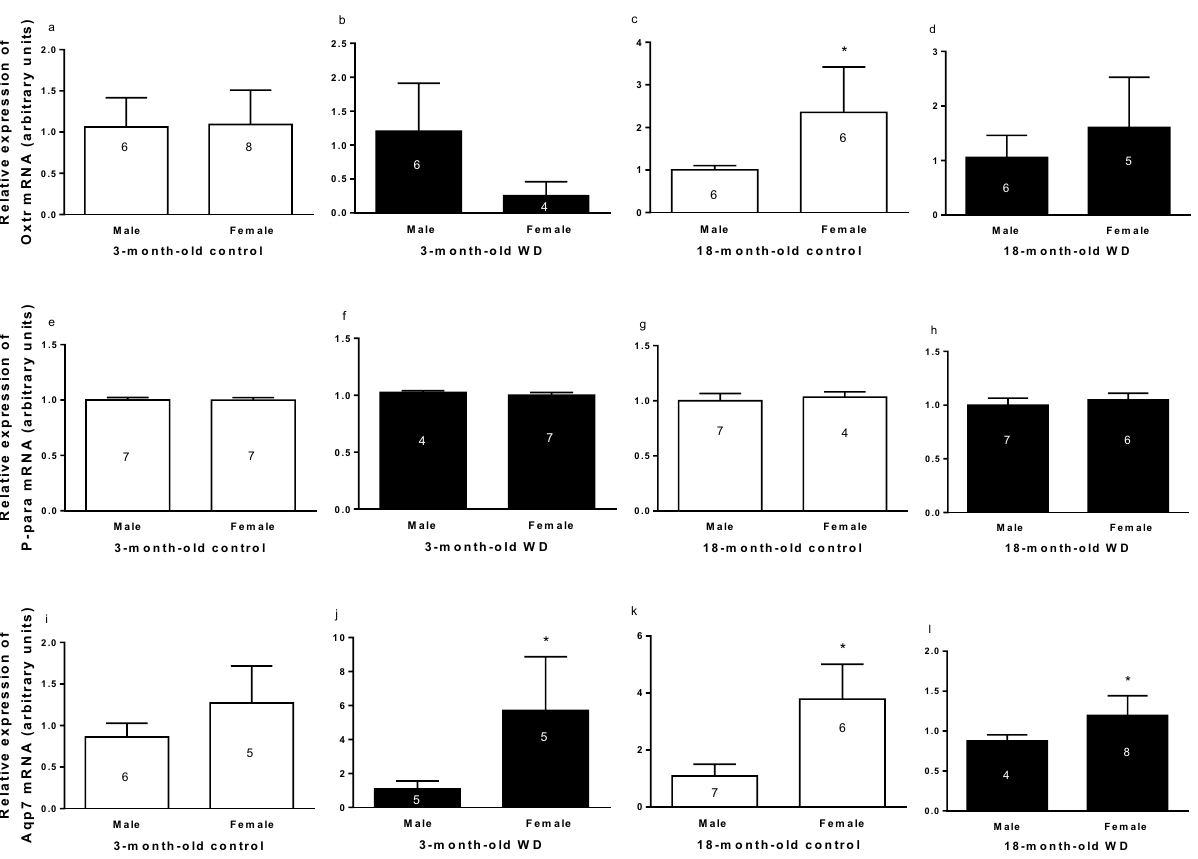
Figure 8. Relative expression of Oxtr ( a – d ), Ppara ( e – h ) , and Aqp7 ( i – l ) mRNA in R-WAT of 3- and 18-month- old control and male and female rats with water deprivation (WD). Comparing by sex. Data are presented as means (SD), *p < 0.05 with respect to male. Student’s unpaired t-test. The n for each group is inside or above the